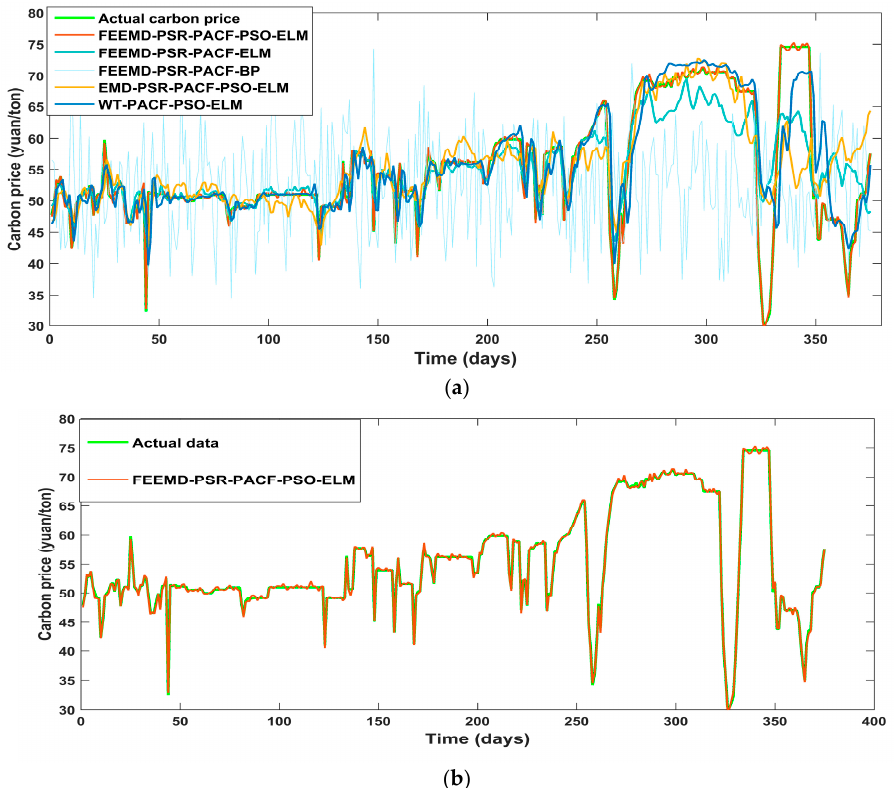
Figure 15. ( a ) The carbon price forecasting curves; ( b ) The comparison between the proposed model and the actual carbon